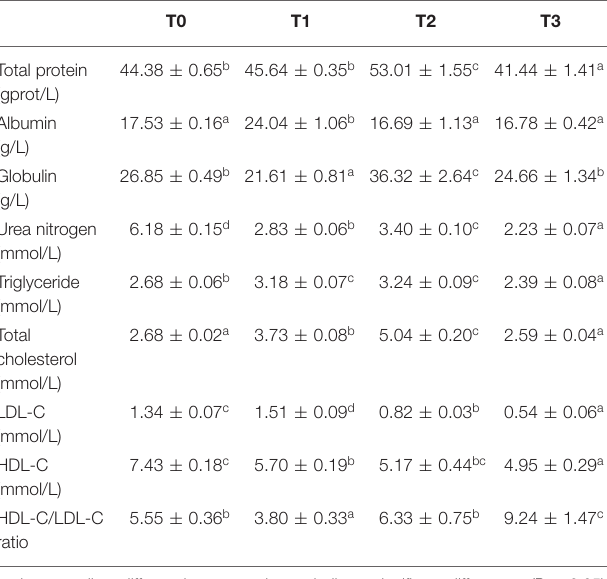
TABLE 9 | Serum parameters of grass carp (means ± SD, n = 4).